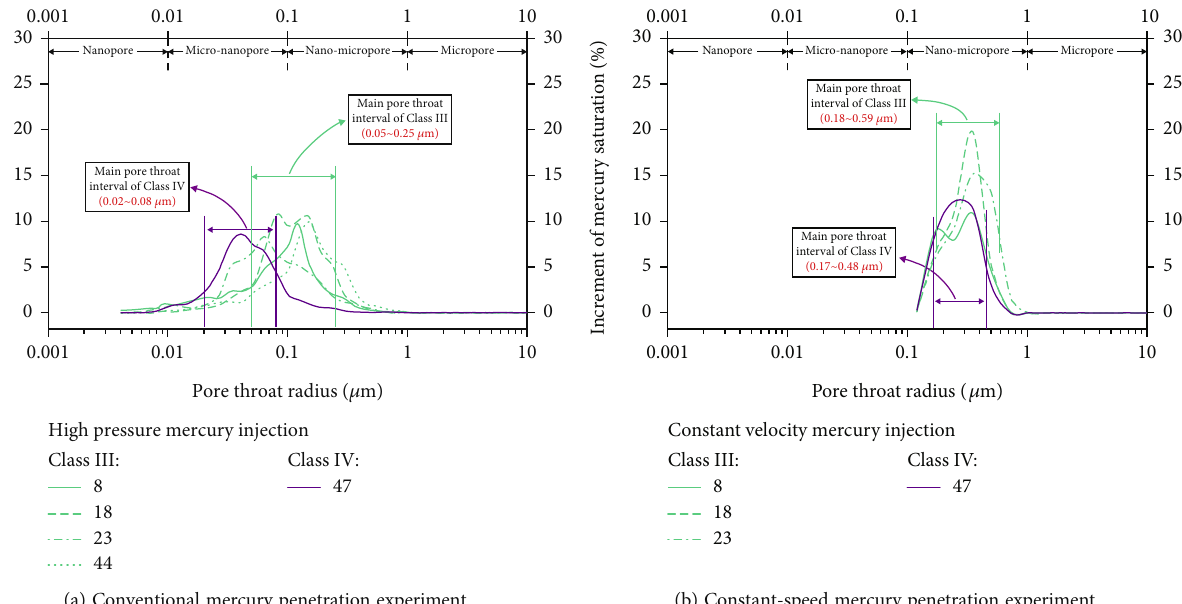
Figure 12: The frequency distribution of pore throat radius of C 7 reservoir.